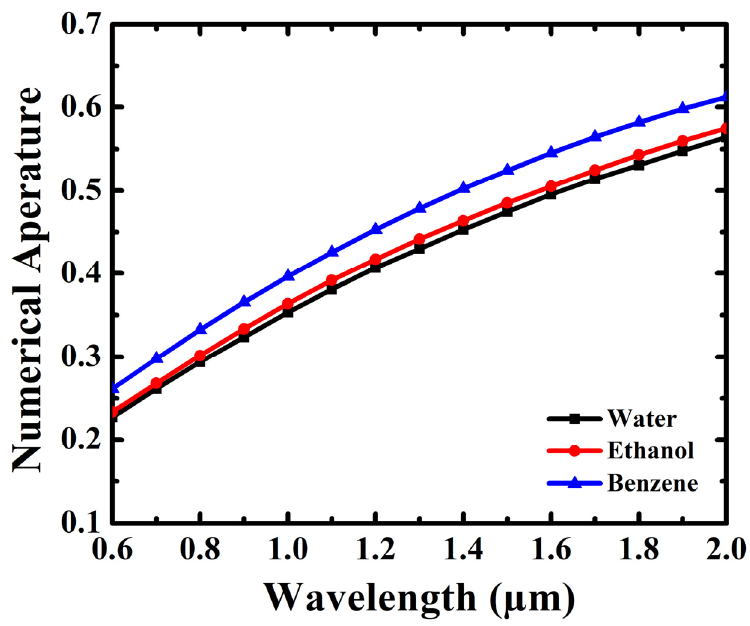
Figure 11. Numerical aperture of the PCF sensor with water, ethanol and benzene, for different operating wavelengths.